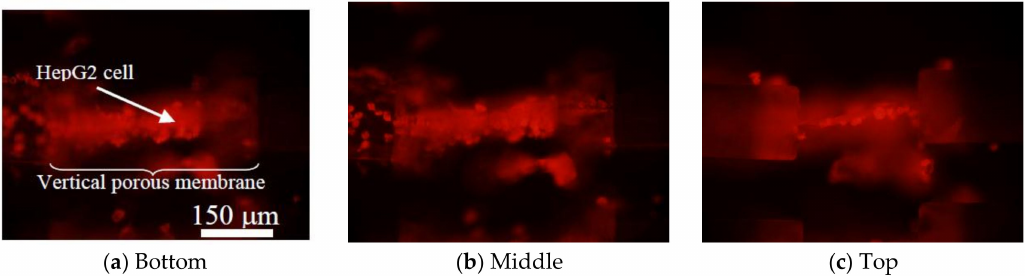
Figure 10. Fluorescent images of cells on a vertical porous membrane integrated microchannel. Two days after seeding, HepG2 cells adhered to the vertical porous thin film. Cell images were obtained by changing the focal length of the microscope, and the cells were observed at each height of the vertical porous